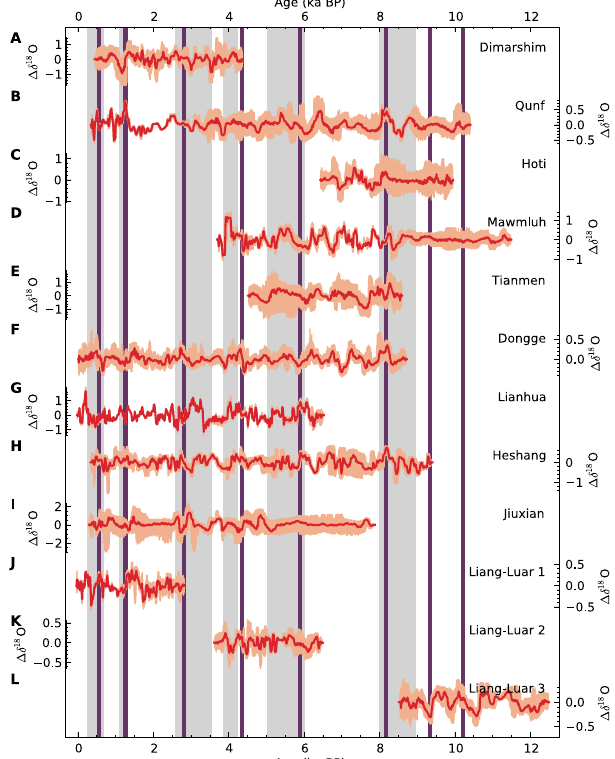
Figure A1. Residual oxygen isotope records (cid:49)δ 18 O analysed in this study (all measured in units of ‰ VPDB). Median (thick red lines) and 90% confidence intervals (orange shading) from an ensemble of 100 time series realisations of the COPRA algorithm for transferring dating uncertainties to uncertainties in proxy values are shown (Breitenbach et al., 2012b). Bond events (violet lines) and RCC episodes (grey bands) are displayed for reference. Note that the Liang Luar record had to be divided into three sections with a temporal resolution sufficiently high for applying the COPRA